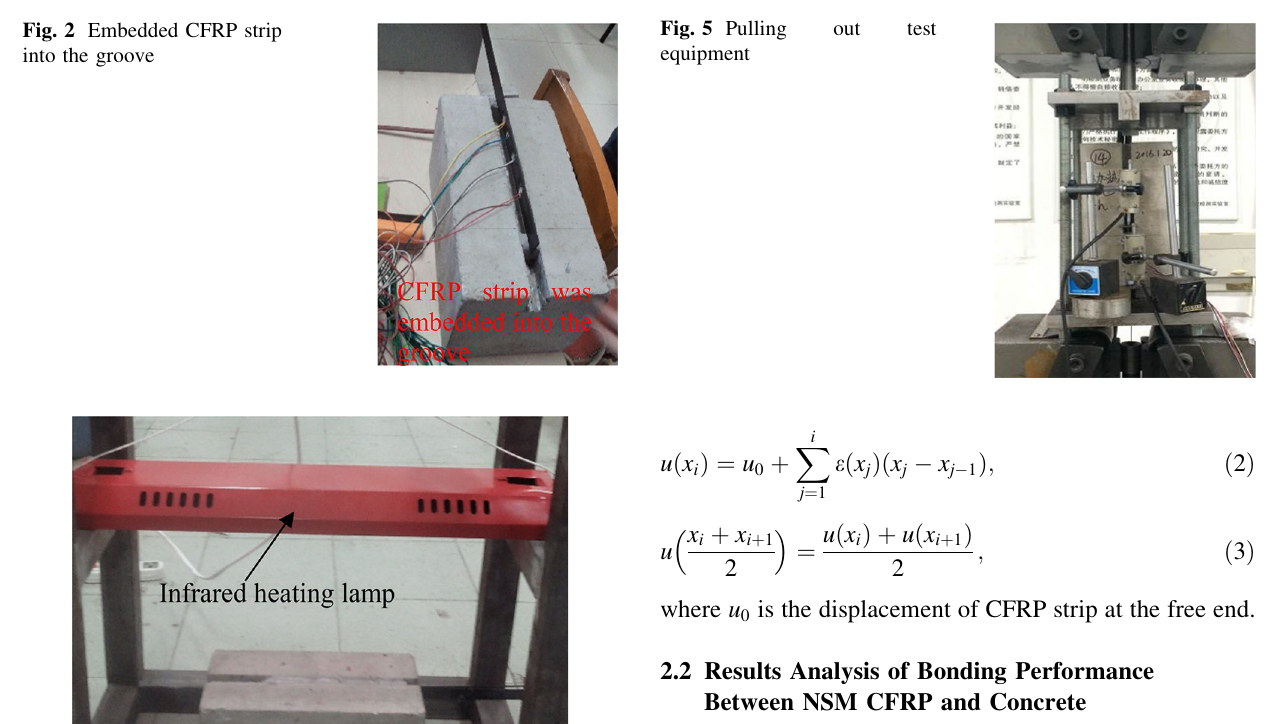
Fig. 2 Embedded CFRP strip into the groove